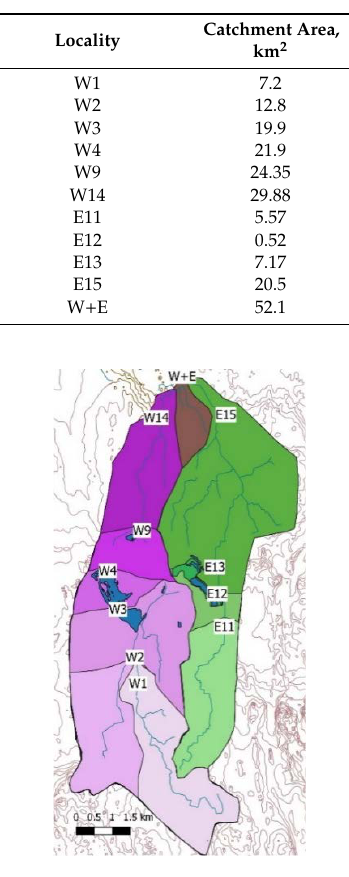
Figure 6. Map of catchment areas.